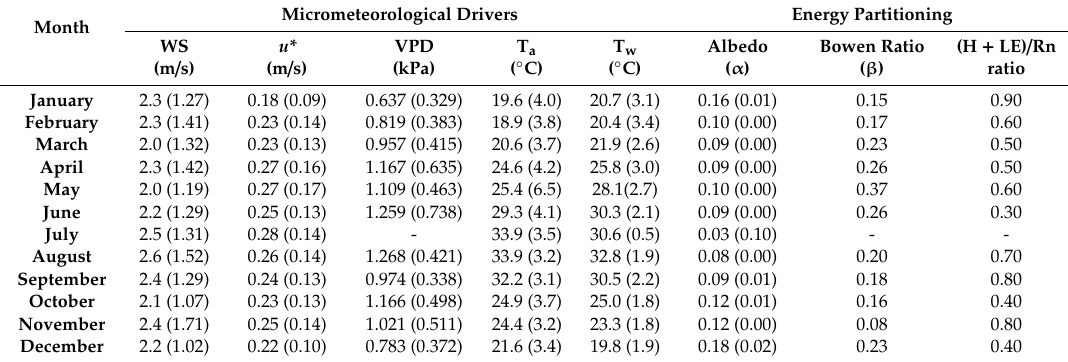
Table 1. Estero El Soldado coastal lagoon monthly average (and standard deviation in parentheses) of micrometeorological drivers and energy partitioning ratios. From left to right WS (wind speed), u* (friction velocity), VPD (vapor pressure deficit), Ta (air temperature), Tw (water temperature), H (sensible heat flux), LE (latent heat flux), and Rn (net radiation). Micrometeorological